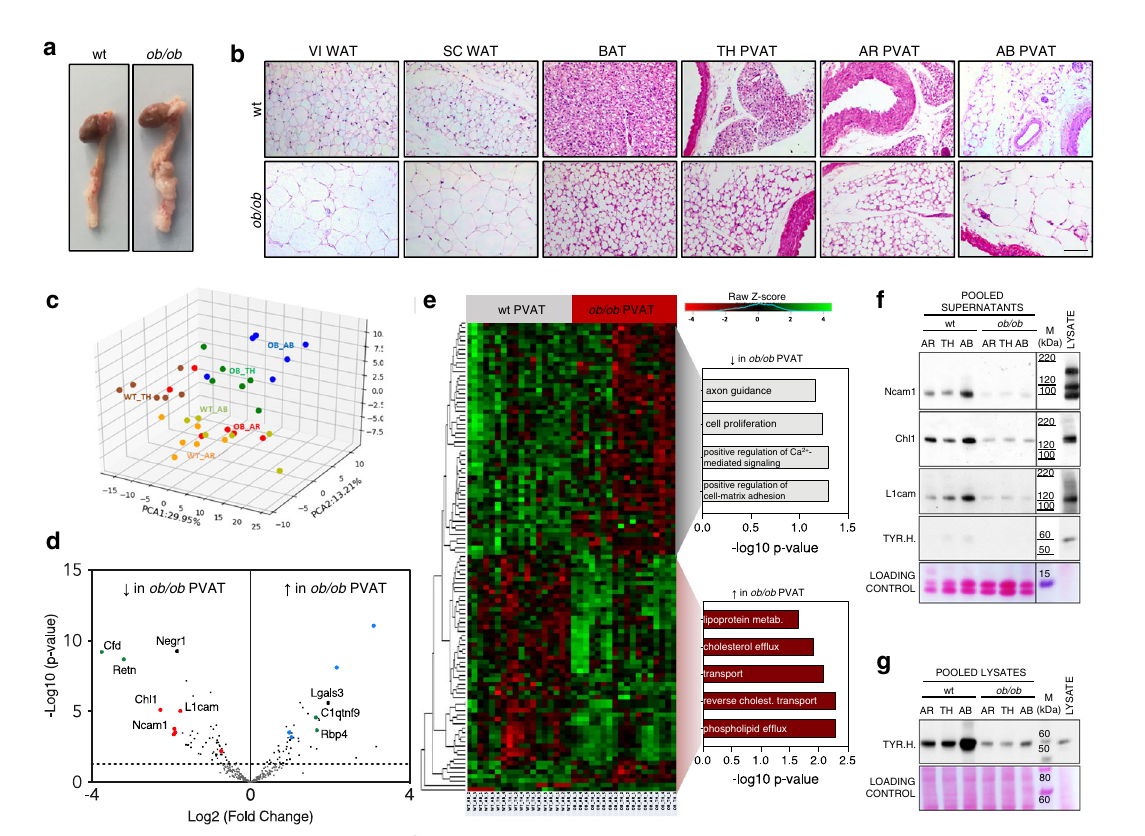
Fig. 3 | Obesity-induced alterations of PVAT phenotype and secretory pro fi le. a Representative pictures of heart, aorta and PVAT dissected from wt and ob/ob mice. b H&E stainings (from 1 out of 3 replicates) on wt and ob/ob AT depots sections. Scale bar: 100 µ m. c Principal Component Analysis of the 293 secreted proteins consistently detected by MS in the conditioned media of wt and ob/ob PVAT explants. d Volcano plot showing proteins differentially secreted by wt and ob/ob PVAT samples ( N =18 vs. 18, with N =6 biological replicates per depot). The limma package was used to compare different groups using the Ebayes algorithm (unpaired analysis) followed by Benjamini – Hochberg adjustment. Green spots: well-established adipokines. Blue spots: proteins involved in lipid transport. Red spots: proteins involved in axonal guidance. e Heatmap showing the 107 secreted proteins signi fi cantly up- or downregulated in the secretomes of ob/ob PVAT explants with Gene Ontology analysisshowing the Biological Processes categories